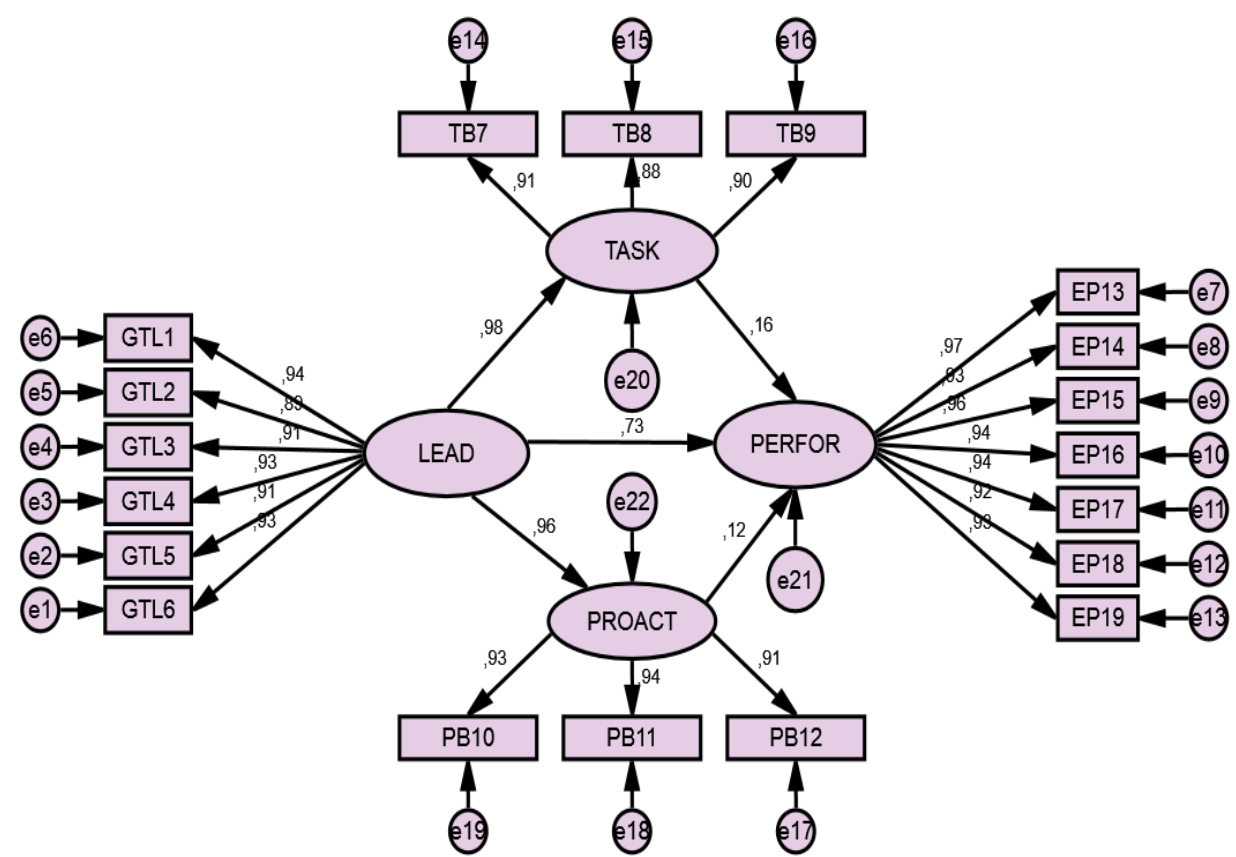
Figure 2. The Research Final Structural Model .